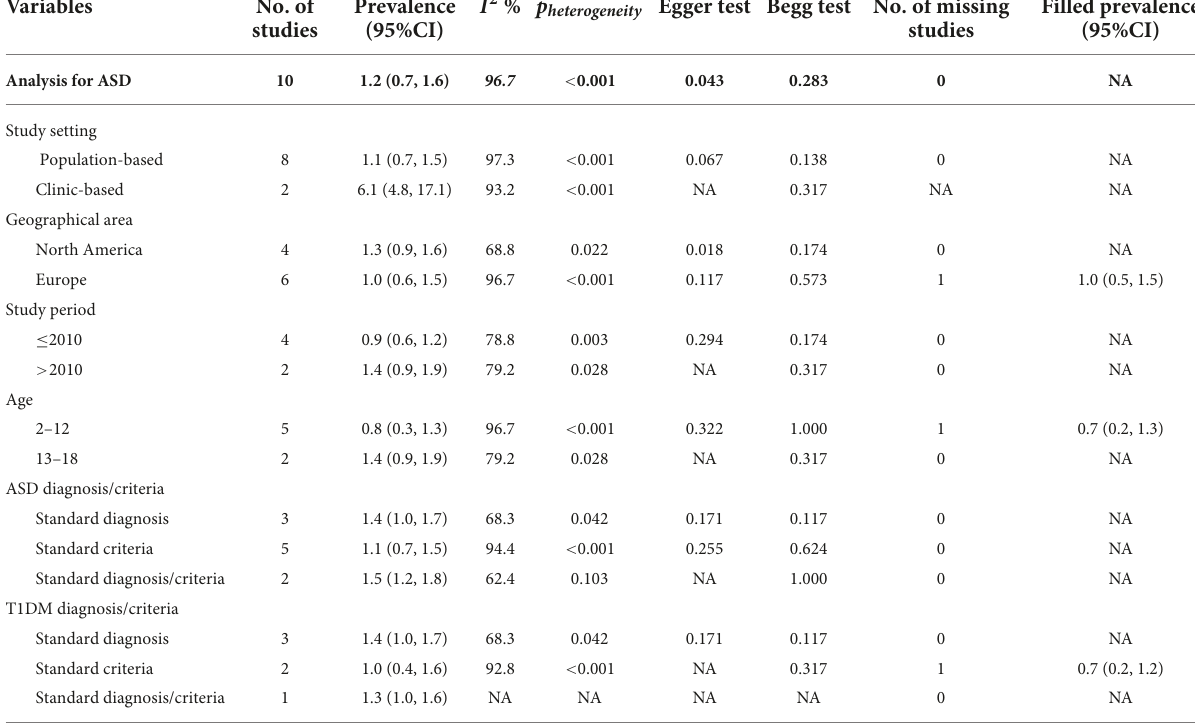
TABLE 1 ASD in T1DM populations using random-effects meta-analysis and subgroup meta-analysis.